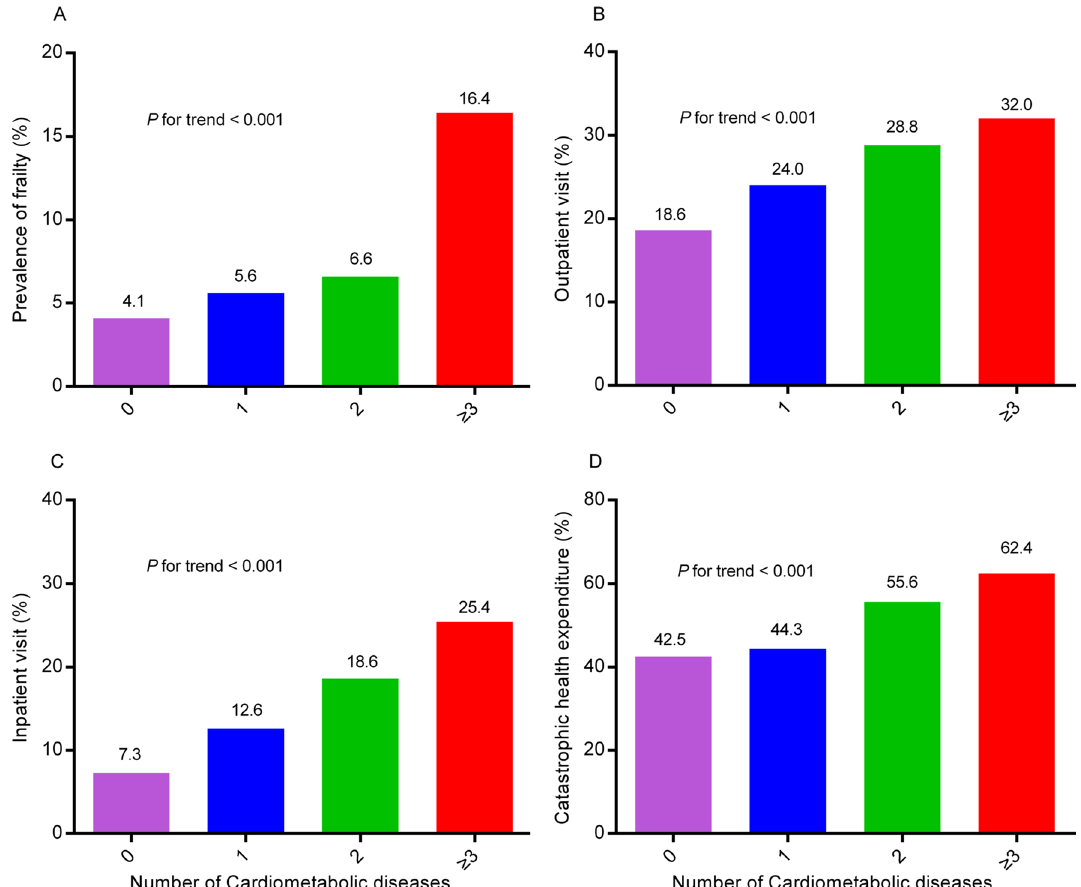
Figure 1. Prevalence of frailty, and healthcare utilization and expenditure by counts of cardiometabolic diseases. Column graph describing the prevalence of ( A ) frailty, ( B ) outpatient visit, ( C ) inpatient visit, and ( D ) catastrophic health expenditure, stratified by counts of cardiometabolic diseases.